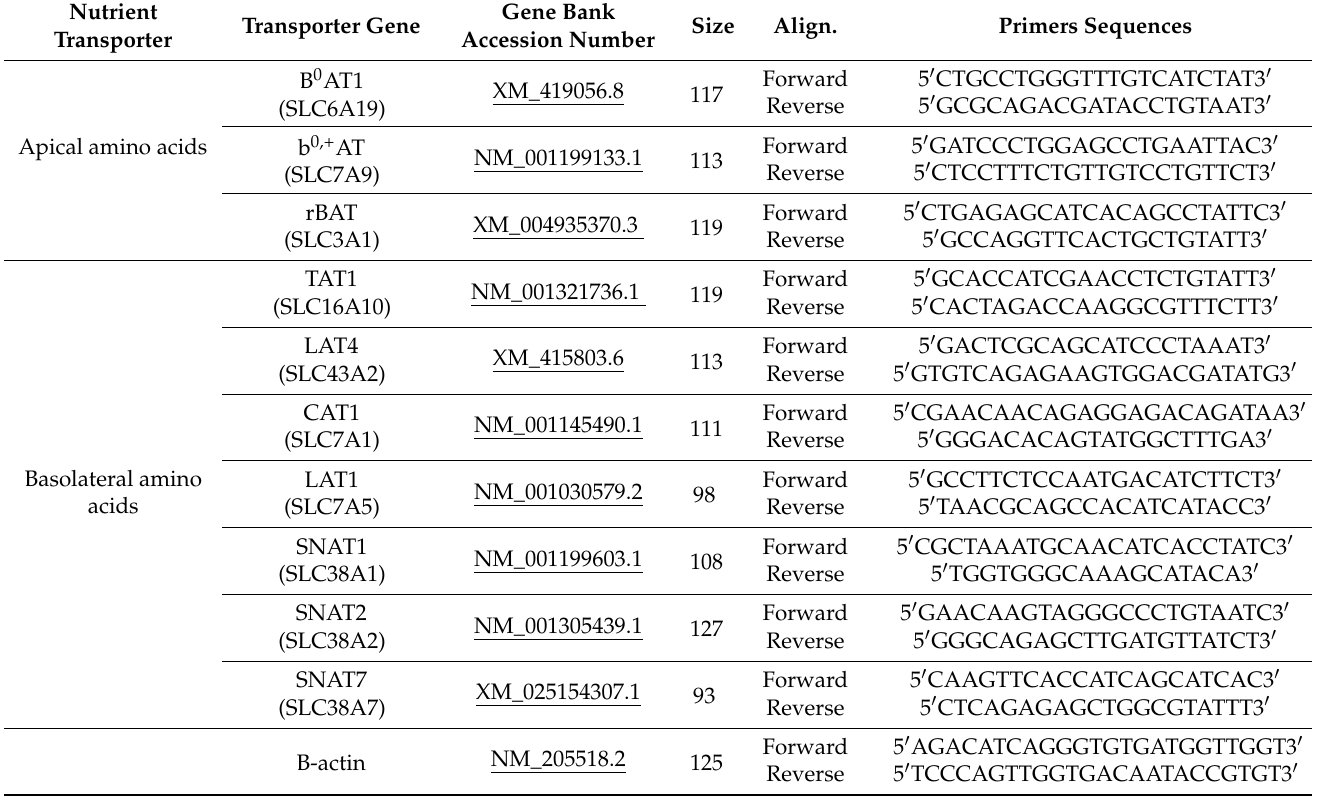
Table 1. Primer used to detect the expression levels of the amino acids’ transporters using RT-qPCR. Gene Bank Nutrient Align. Primers Transporter Gene Transporter